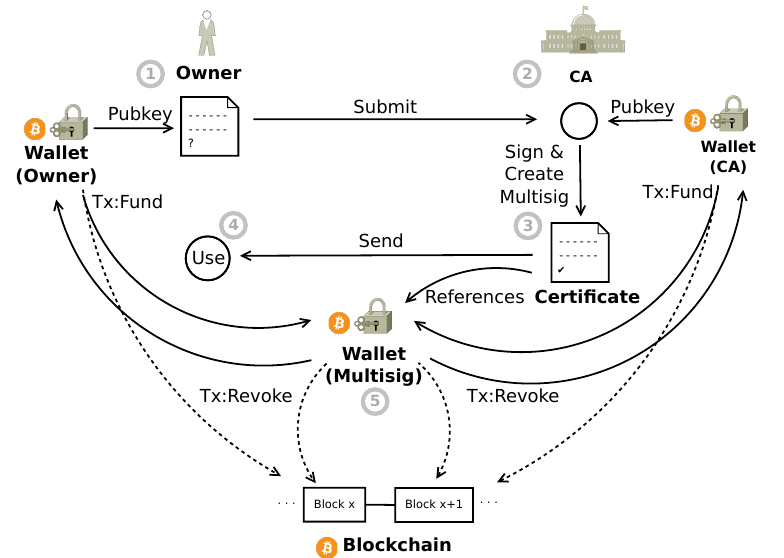
Figure 3. The BlockVoke certificate lifecycle (Based on